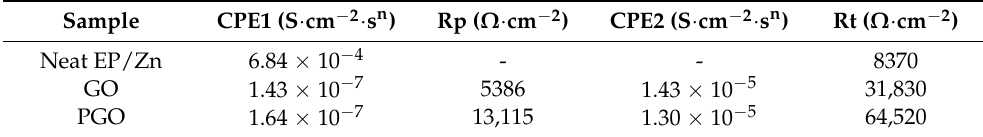
Figure 10. Nyquist diagrams of neat EP/Zn, GO/EP/Zn, and PGO/EP/Zn samples after 300 h of immersion in 3.5 wt.% NaCl solution and the fitted data based on the inset equivalent circuit. Table 4. Electrochemical parameters extracted from the EIS results for the three coating samples.